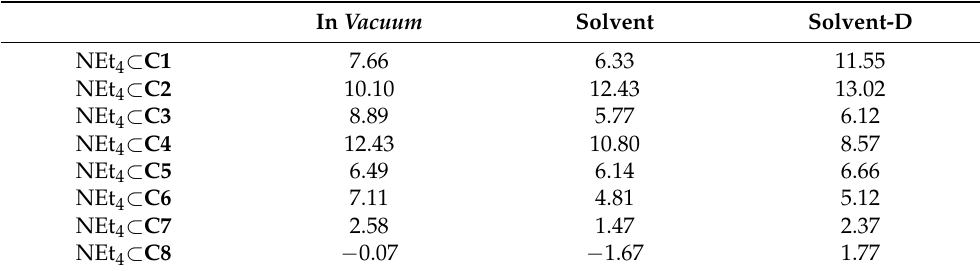
Table 2. Calculated values for the relative stability ∆ E H–M of helicate/mesocate isomers for NEt 4 ⊂ C cages ( C1 – C8 ) are reported. ∆ E H–M is the difference between helicate and mesocate in kcal/mol. A positive value means a more stable helicate with respect to the mesocate, while a negative value denotes the